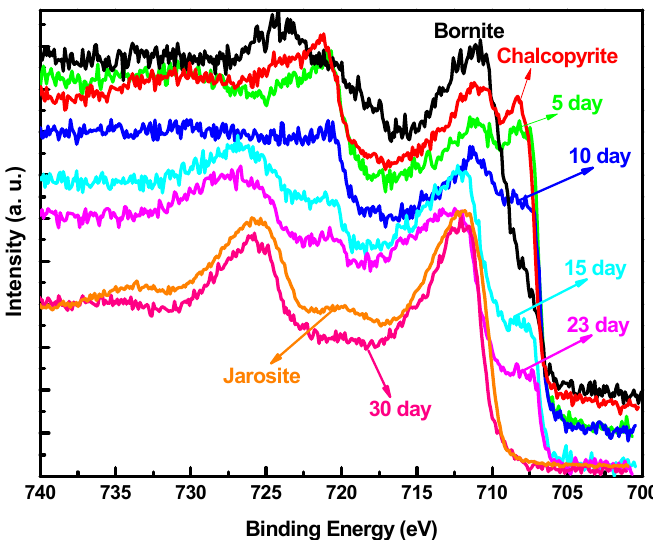
Figure 7. Fe 2p peaks of co-bioleaching chalcopyrite and bornite (ratio of Ccp/Bn was 3:1).